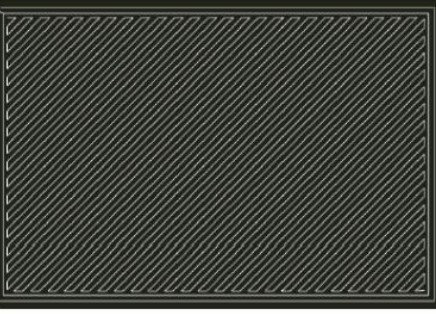
Figure 2. Direction of deposition of the individual layers; top and bottom layers and FO samples. Three macro-typologies of specimens were created and referred to below as FO (full Onyx), 0FC (zero fibre content), and 090FC (090 fibre content). For 100% filler (FO), all the Onyx layers are deposited as the top and bottom ones above are. The reinforced configurations (0FC and 090FC) are characterised by the same fibre volume fractions Vf = 69% and different layup sequences (Figure 3). Each layer of the stratified panel is about 0.125 mm in thickness, with a final thickness of the samples equal to t = 2 ± 0.2 mm. In 0FC composites, the fibre is deposited at 0 ◦ with respect to each layer’s plate. In 090FC samples, the fibre is deposited alternatively at 0 and 90 degrees. A deposition speed of 2.39 cm 3 /h for the carbon fibre layers was applied for both configurations. Five samples of each specimen configuration were